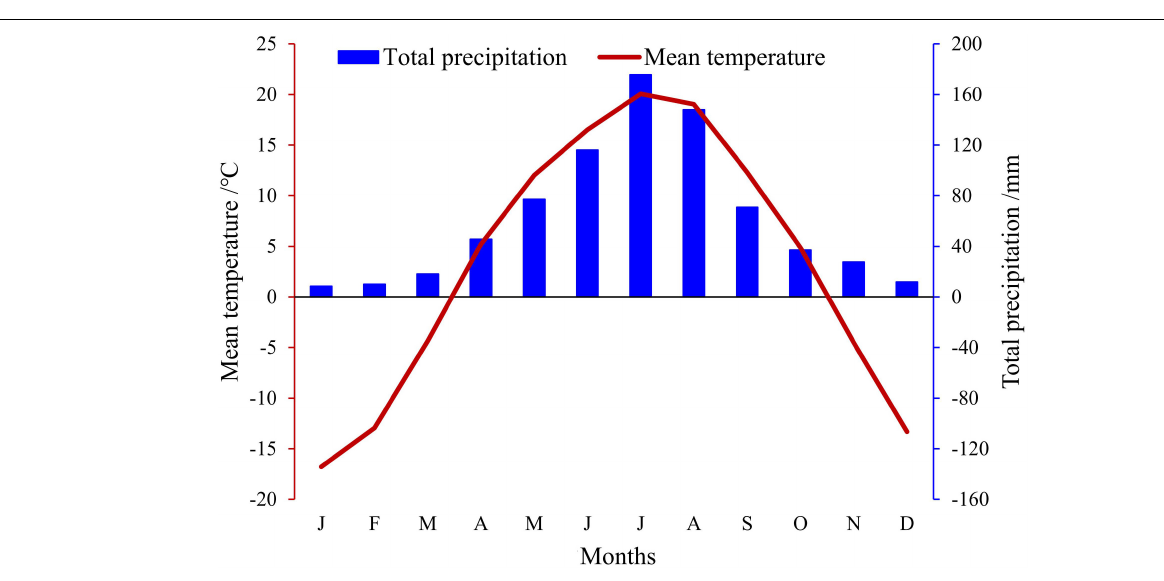
confidence level (Briffa and Jones, 1990), and a threshold value of 0.85 is often used to evaluate the useful and valid time span of the final chronologies (Wigley et al., 1984). Gleichläufigkeit index was calculated to measure level of agreement between consecutive ring width slopes. The degree of similarity between two series based on